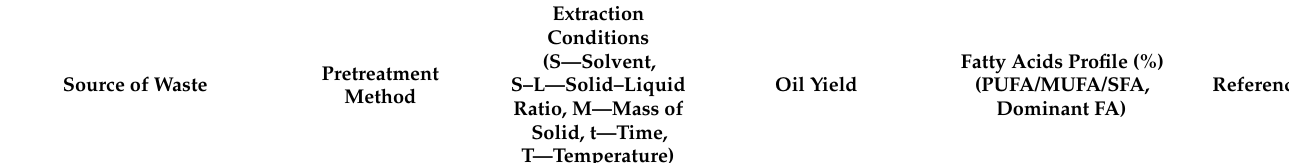
Table 4. Characteristics of lipid fractions extracted from berry by-products using conventional